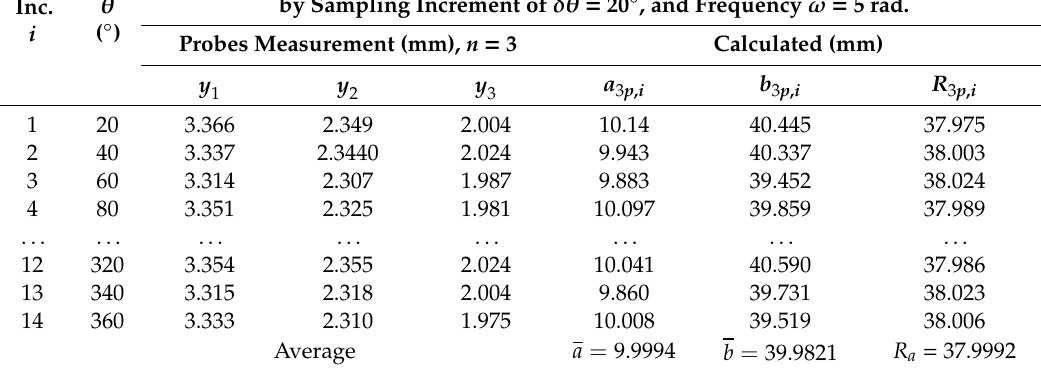
Table7. CalculationofRoundnessfor R p = 38 / 40mm, R e = 38 mm, andfrequency ω = 5rad.